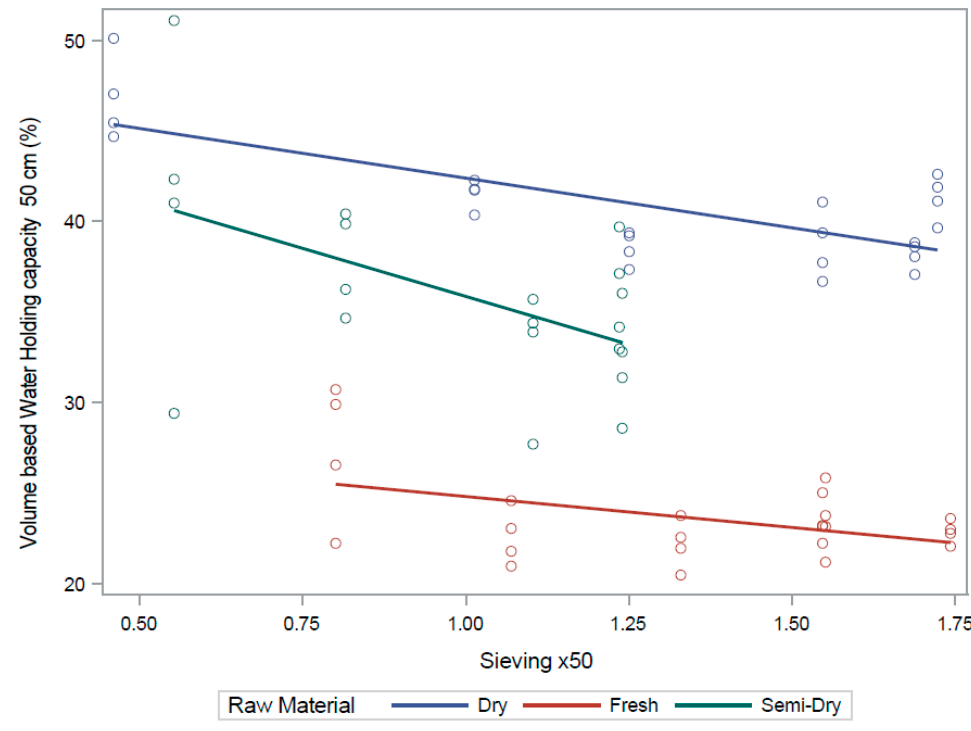
Figure A3. Correlation between WHC − 1 kPa (volume based) and X-50.